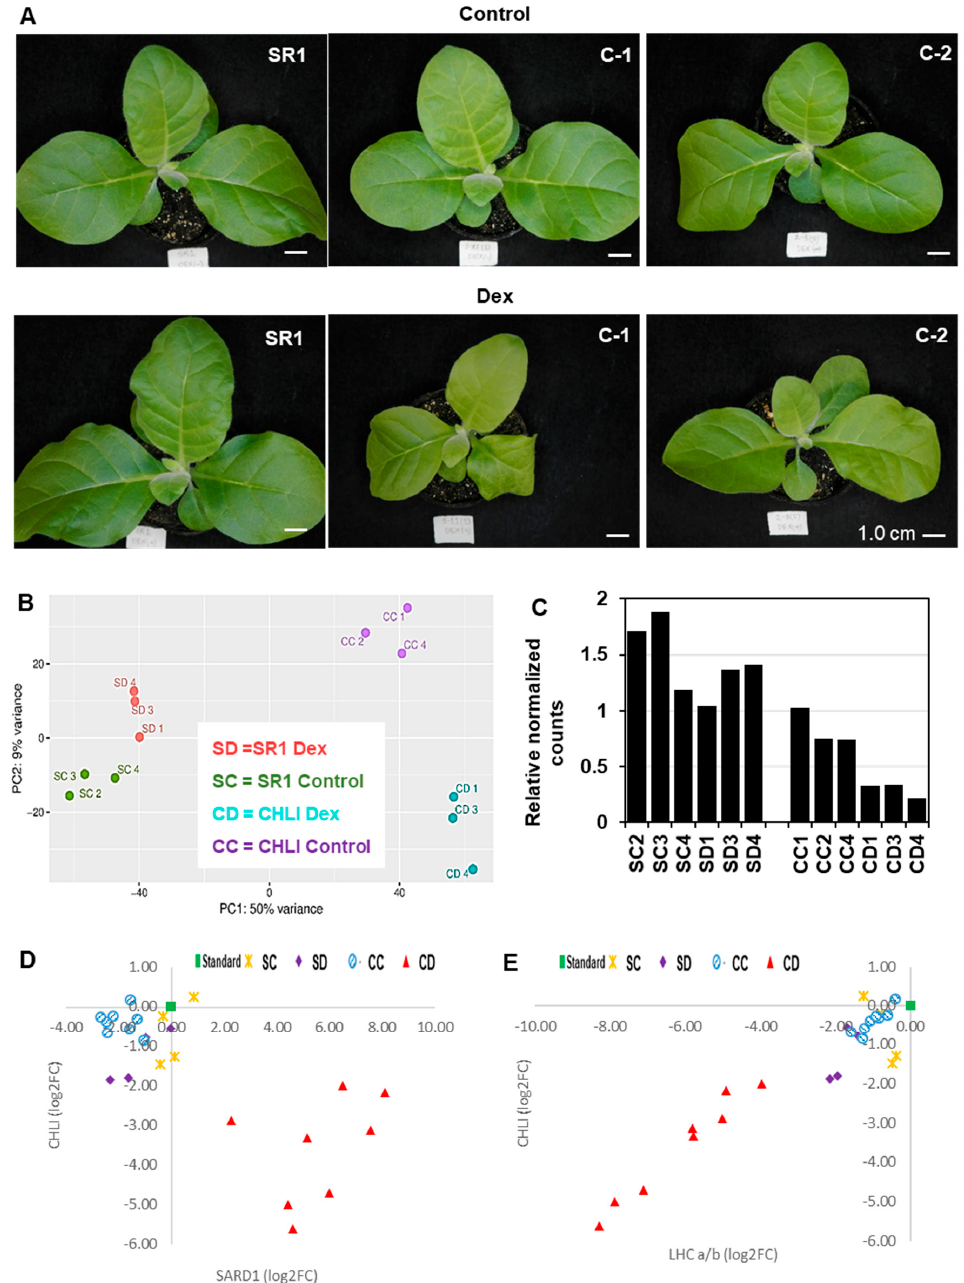
Figure 1. Phenotype and transcriptome change after induced silencing of CHLI in transgenic tobacco plants. ( A ) Non-transformed tobacco (SR1), i-amiCHLI-1 (C-1) and i-amiCHLI-2 (C-2) plants were grown for three weeks, sprayed with 0.01% Tween-20 containing 0.5% ethanol (control) or 50 µM Dex (Dex), and photographed at 7 days post-treatment (dpt). Scale bars indicate 1 cm. ( B ) Principle component analysis (PCA) of RNA-seq data. RNA preparations from 1-dpt control-treated SR1 (SC2, SC3, and SC4) and Dex-treated SR1 (SD1, SD3, and SD4), control-treated C-1 (CC1, CC2, and CC4), and Dex-treated C-1 (CD1, CD3, and CD4) were analyzed using DESeq2. ( C ) The relative expression level of CHLI in all RNA-seq samples from DESeq2 analysis. ( D , E ) Expression analysis of SARD1 ( D ) and LHC a / b ( E ). The expression levels of these genes relative to a fixed standard sample (square) were quantified in eight individual plants each of control- (circles) and Dex-treated (triangles) i-amiCHLI-1 plants, and in four individual plants each of control- (crosses) and Dex-treated (diamonds) SR1 plants. The relative expression values were plotted with those of